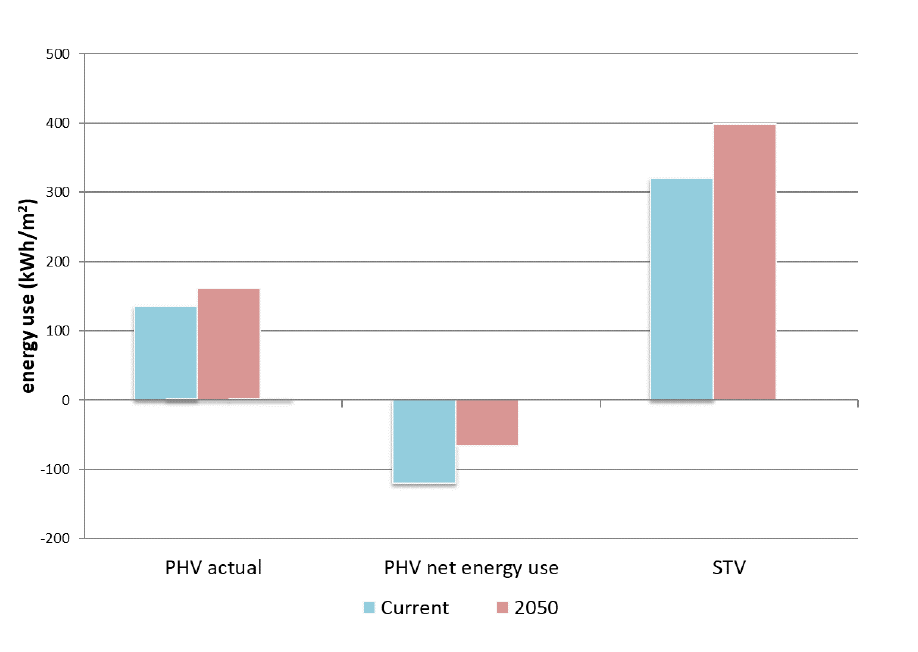
Figure 7. Annual energy use in the PHV and STV in the present time and the future (2050) b.